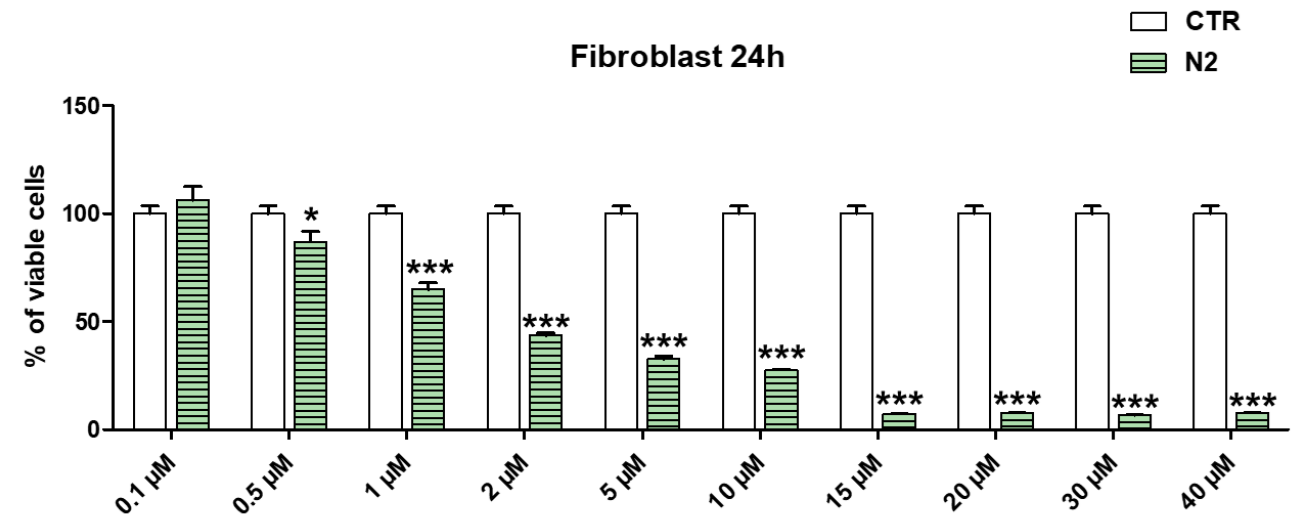
Figure 3. Results from dose-dependent cytotoxicity experiments carried out on MAIL-2 human cells at 24 h exposure to OP2 (N2 = OP2, CTR = control). * = p < 0.05, *** = p < 0.001.